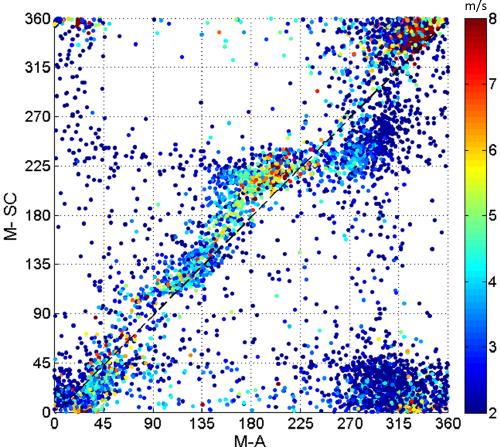
Figure 3. Wind direction comparison between M-A and M-SC for 1 year. The coloured data indicate mean wind velocity values (ms − 1 ) from both